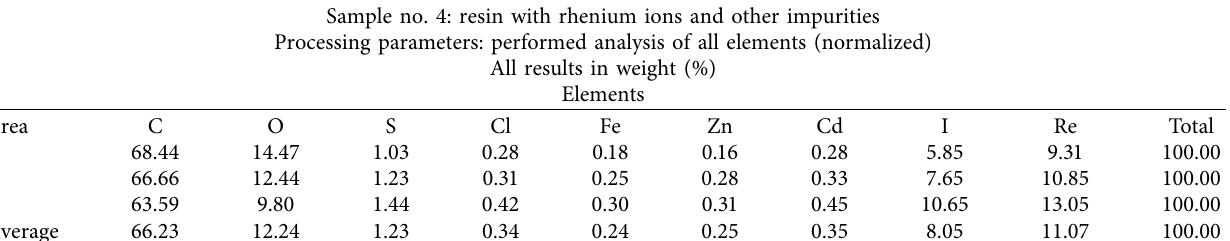
Table 5: Results of analysis of rhenium-saturatedion-exchange resin.